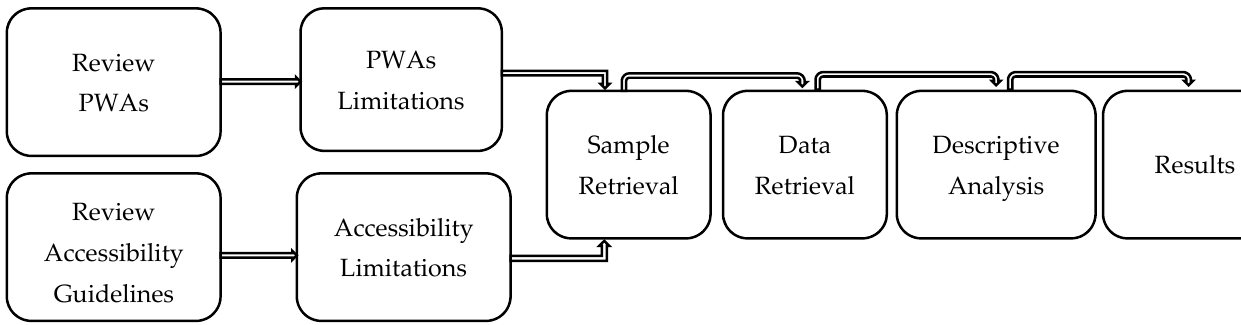
Figure 1. Overall step ‐ by ‐ step representation of the proposed methodology, reflecting the stages for evaluating PWAs’ accessibility.